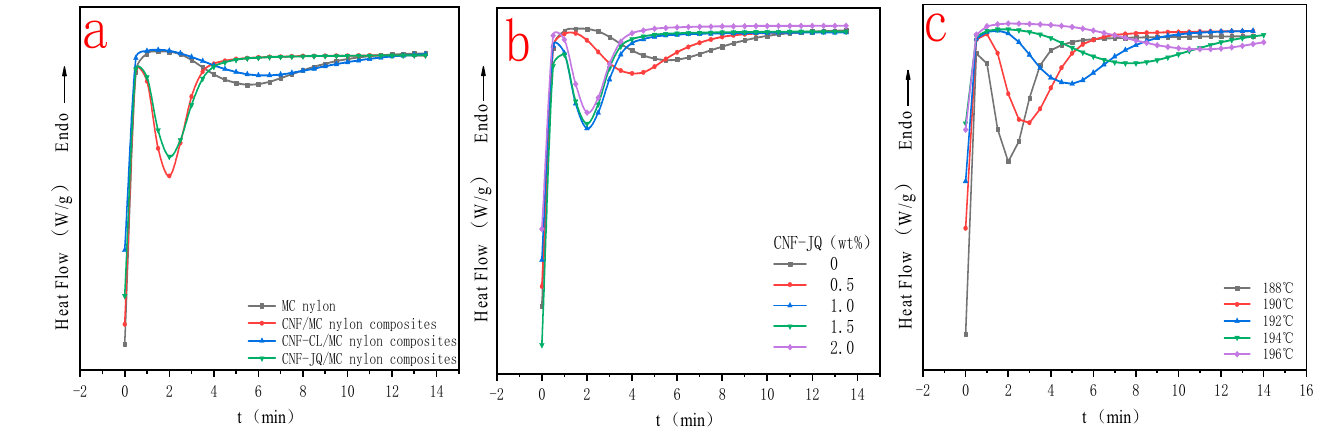
Figure 7. Heat flows as a function of time for MC nylon and MC nylon composites (( a ) is the curve of different modified CNF with a filling of 1.0 wt% at a cooling rate of 188°C; ( b ) is the curve of different CNF–JQ additions at a cooling rate of 188 °C; ( c ) is the curve of different cooling rates for CNF − JQ of 1.0 wt%).